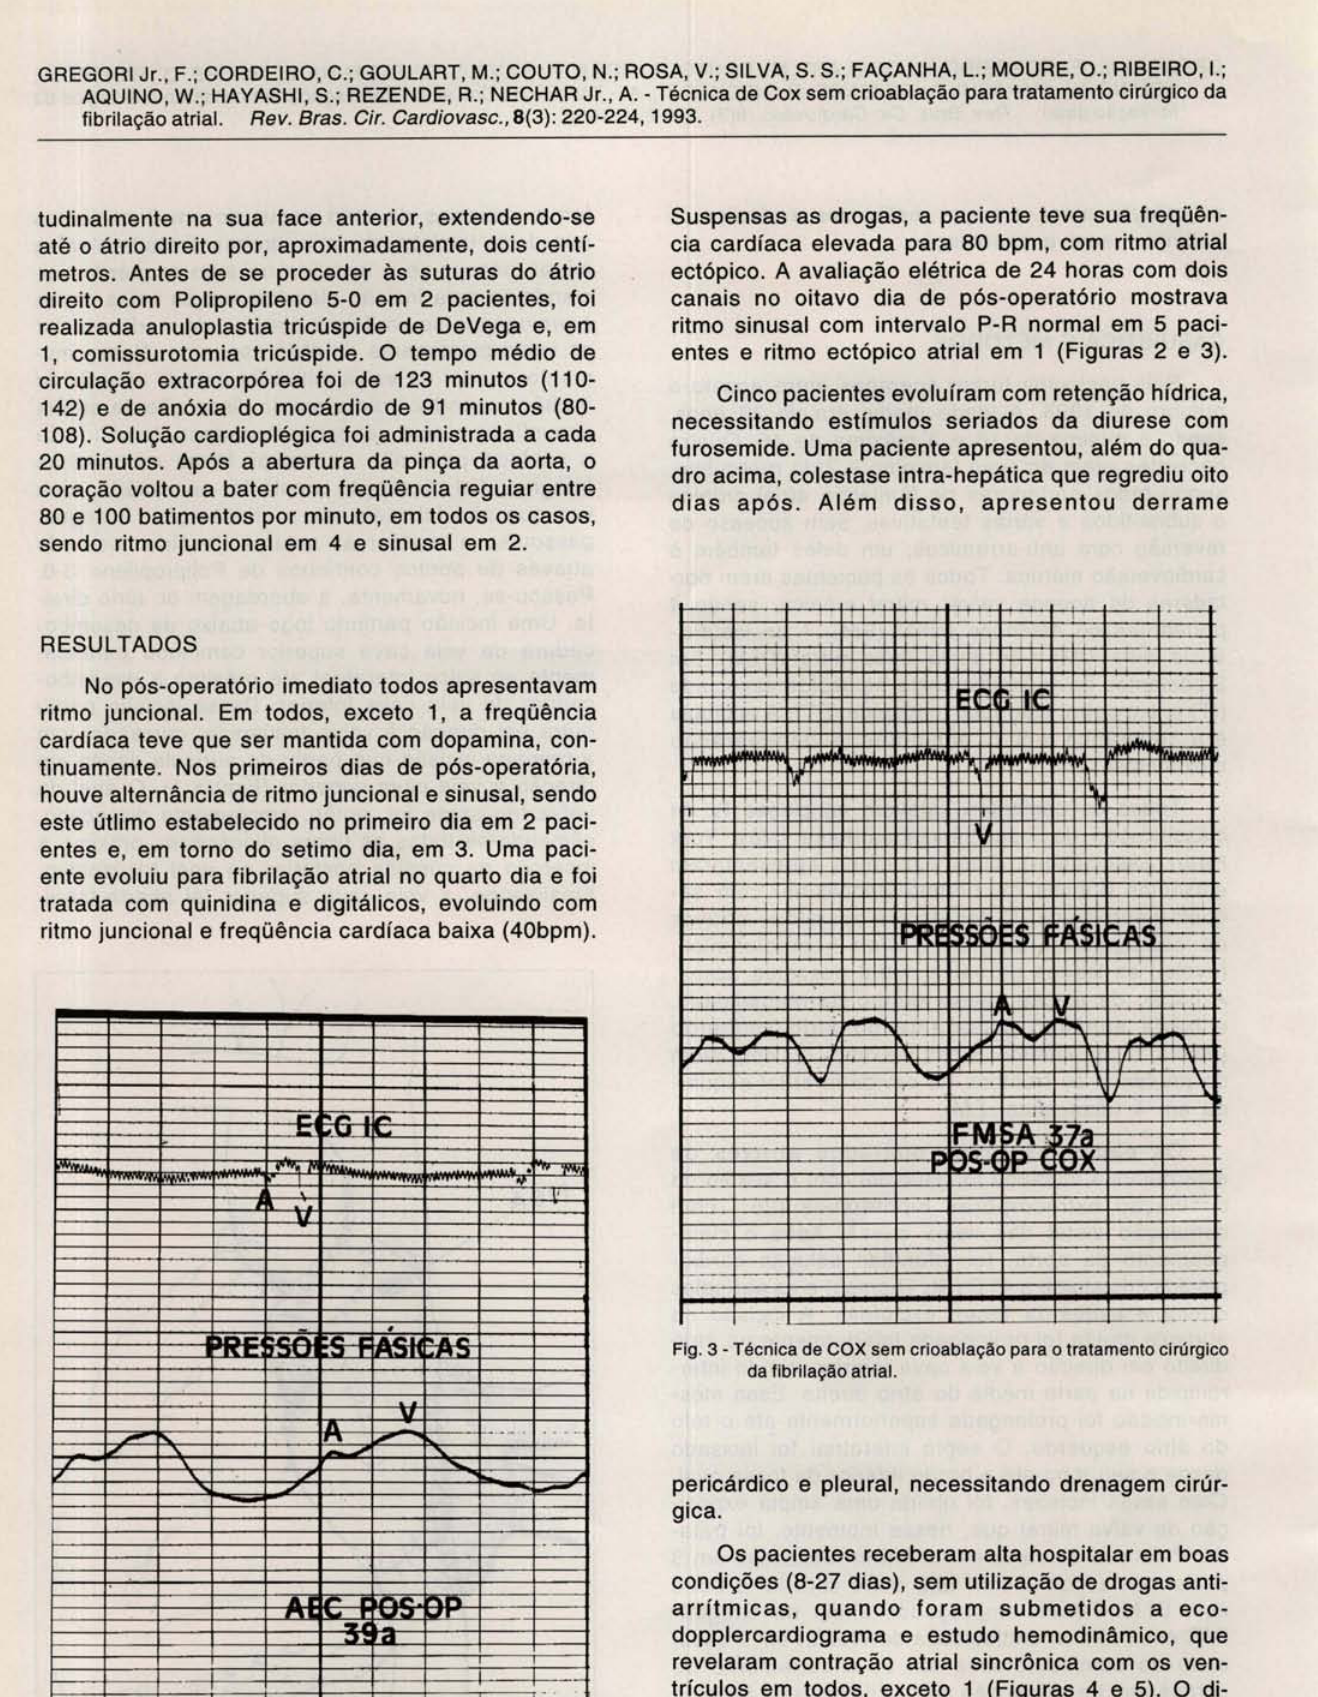
pericárdico e pleural, necessitando drenagem cirúr gica